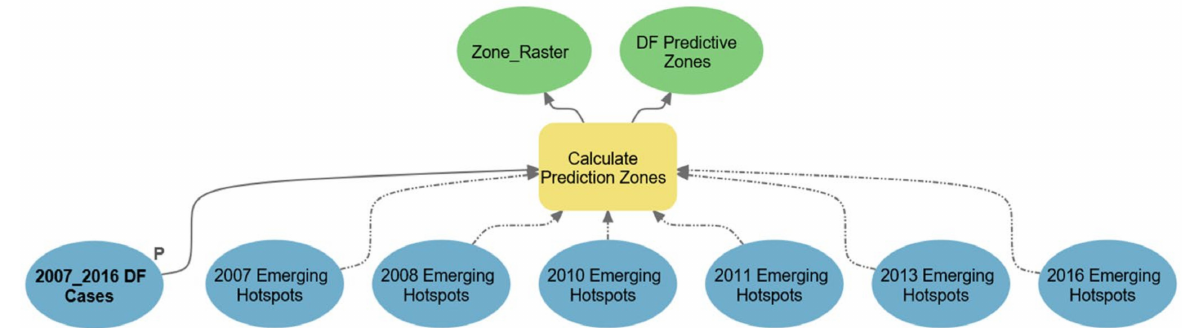
Figure 4. Model showing DF prediction process where one major parameter (P) is DF composite cases. A total of six precondition layers (DF significant space–time hot spots 2007–2016) were also joined. After devising unique spatiotemporal ranges, predictive risk locations were calculated as vector and raster